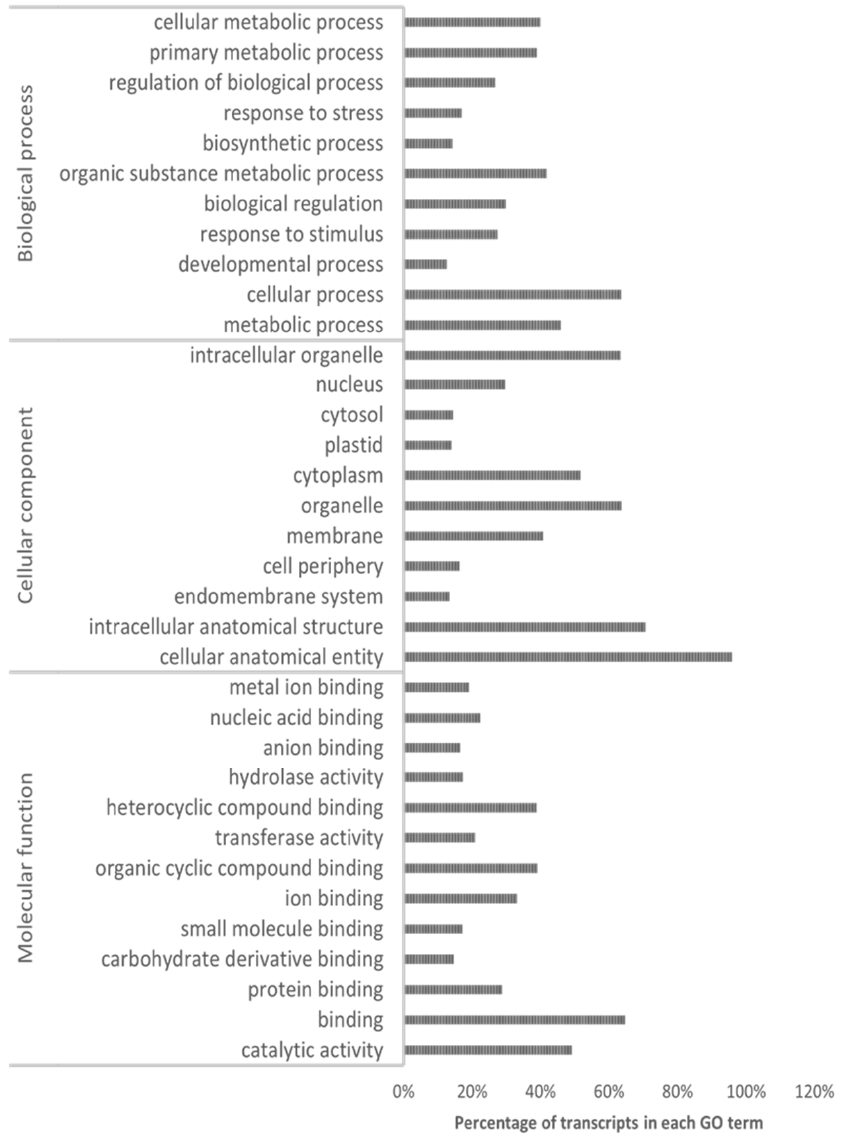
Figure 2. The GO classification of H. incana transcripts in response to Pb stress .